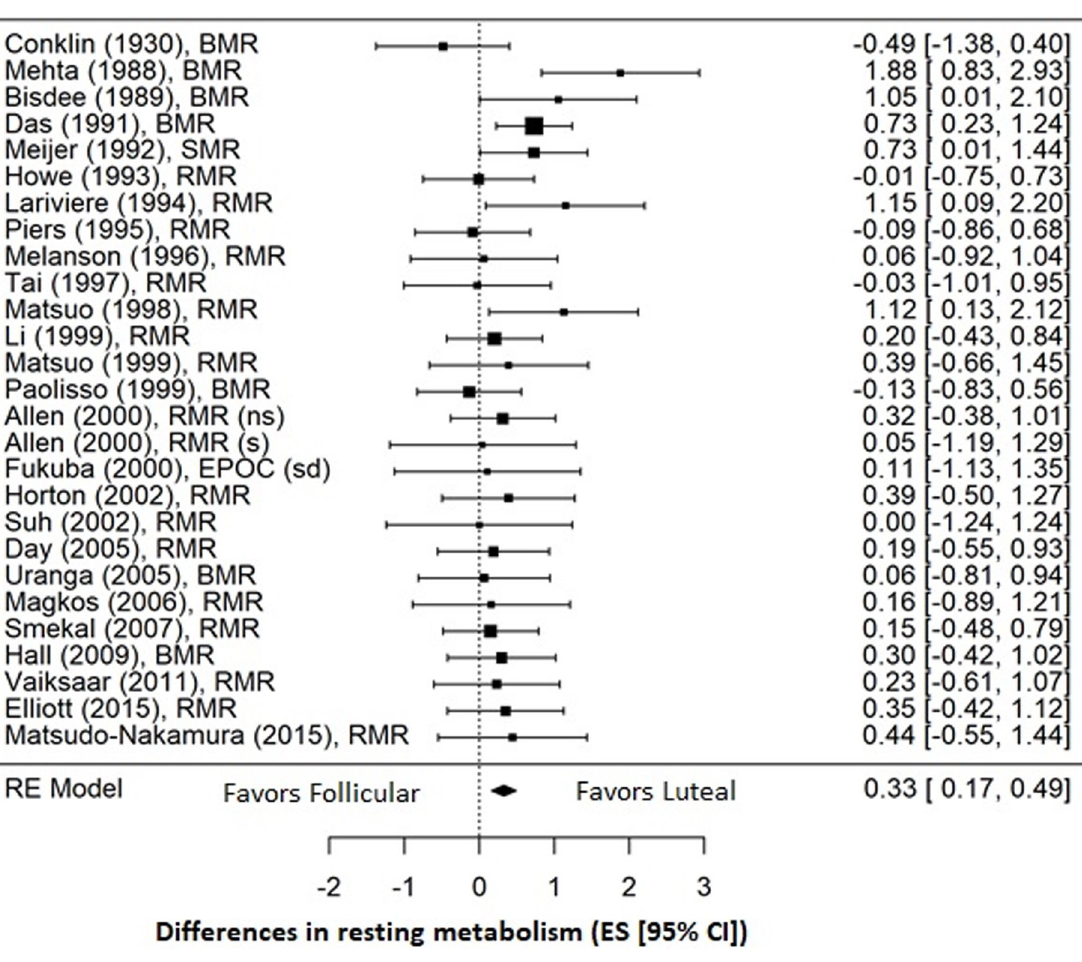
Fig 3. Forest plot of effect sizes for all 26 studies included in the meta-analysis. Studies are listed by first author and year of publication. The overall effect (ES = 0.33) was calculated using a random effects (RE) model and favors an increase in RMR during the luteal phase compared to the follicular phase. (ns) = non-smokers; (s) = smokers; (sd) = standard diet.